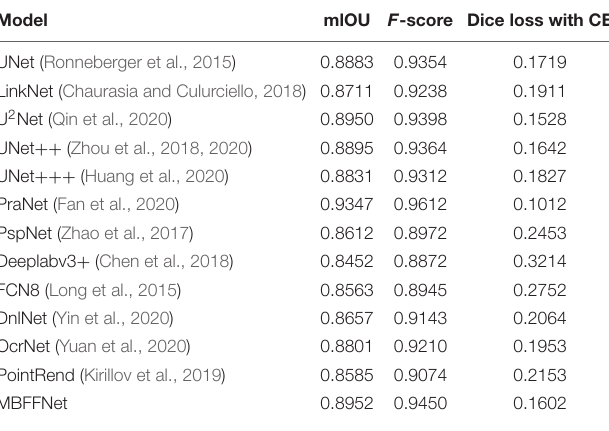
TABLE 2 | Evaluation index of polyp segmentation mIOU, F -score, and Dice loss with CE.